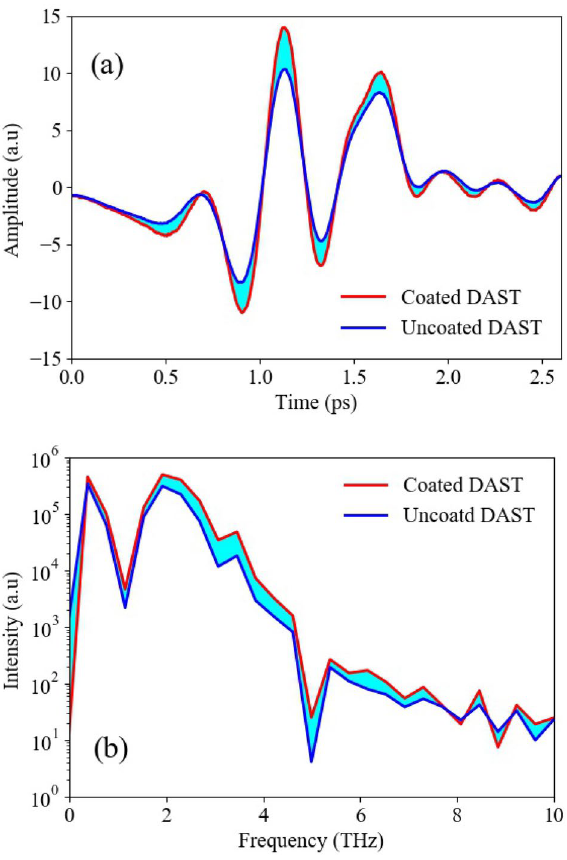
Figure 7. ( a ) THz time domain pulse emitted by AR coated and uncoated DAST crystals and ( b ) their respective intensity spectra. The shaded area shows the difference in terahertz intensity emitted by the two